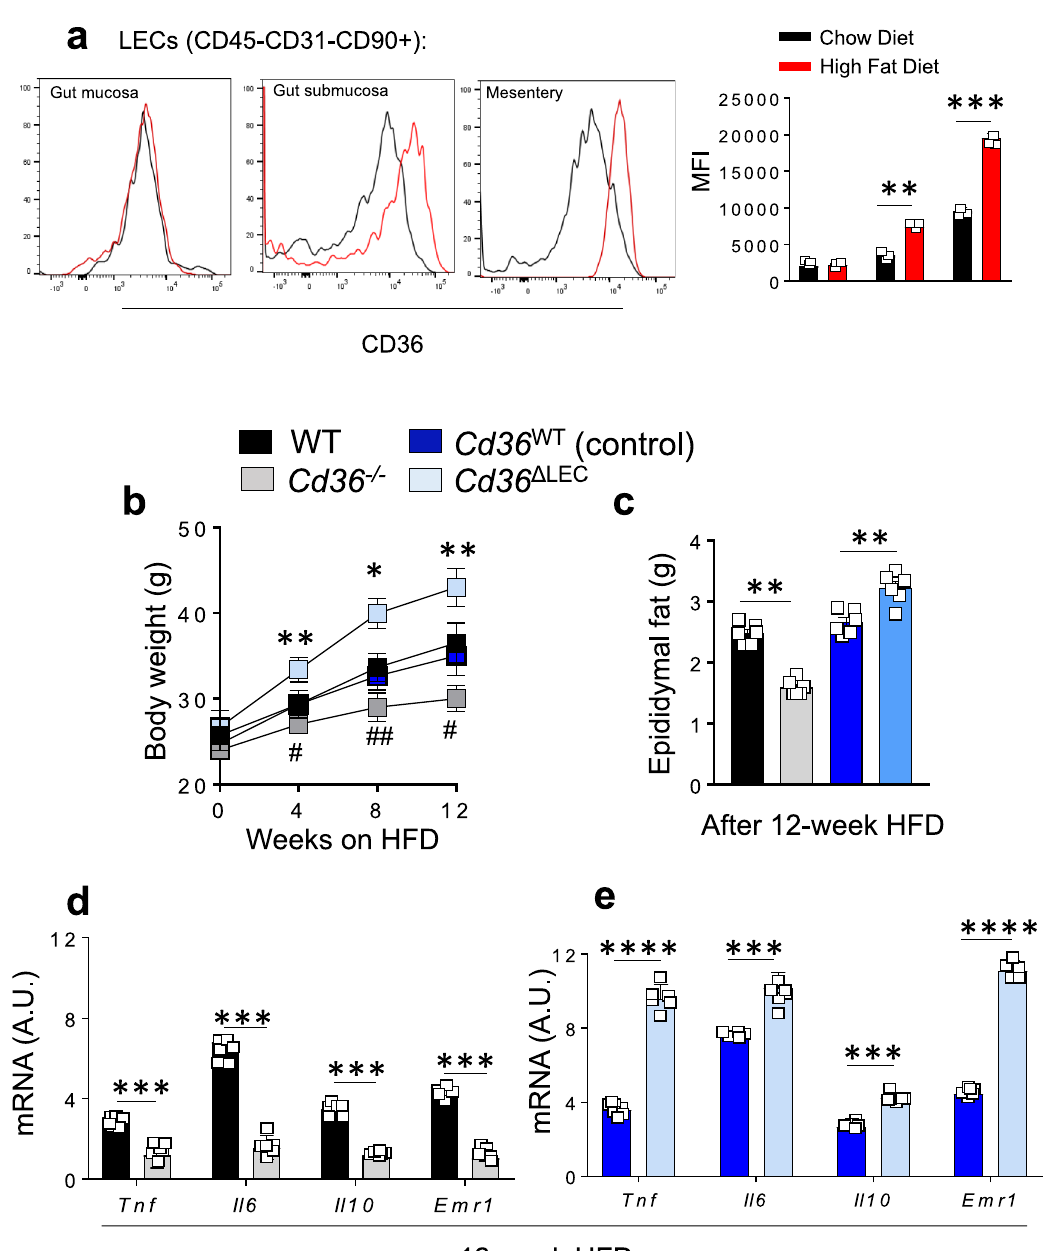
Fig. 6 High-fat diet feeding induces obesity and adipose tissue in fl ammation in Cd36 Δ LEC mice but not in Cd36 − / − mice. a Eight-week-old male and female wild-type (WT) mice ( n = 3) were fed either chow diet (CD) or high-fat diet (HFD) for 12 weeks. CD36 expression was measured by fl ow cytometric analysis in lymphatic endothelial cells (LECs) (CD45 − CD90.2 + CD31 + ) isolated from gut mucosa, submucosa, and mesentery lymphatic vessels. CD36 expression is increased in LEC isolated from gut submucosa and mesenteryic vessels ( P < 0.01 and P < 0.001, respectively). MFI: mean fl uorescence intensity. b Body weight of Cd36 − / − and Cd36 Δ LEC mice, and respective controls ( n = 6), fed HFD for 12 weeks. *Depicts signi fi cance between Cd36 Δ LEC and Cd36 WT mice (4 weeks, P < 0.001; 8 weeks, P < 0.01; 12 weeks, P < 0.001) # , depicts signi fi cance between WT vs Cd36 − / − mice (4 weeks, P < 0.05; 8 weeks, P < 0.01; 12 weeks, P < 0.05). c Epidydimal fat pad weight (g) is decreased in Cd36 − / − mice as compared to WT mice ( P < 0.001), whereas epidydimal fat pad weight is increased in Cd36 Δ LEC mice as compared to controls ( P < 0.01) fed HFD for 12 weeks. d Cytokine gene expression is decreased in Cd36 − / − epididymal adipose tissue as compared to WT mice ( n = 6) fed HFD for 12 weeks. e Cytokine gene expression is increased in Cd36 Δ LEC epididymal adipose tissue as compared to controls ( n = 6) fed HFD for 12 weeks. Tumor necrosis factor alpha , Tnf ; Interleukin-6, Il6 ; Interleukin- 10, Il10; EGF module-containing mucin-like receptor 1, Emr1 . A.U. arbitrary units. All data are from two independent experiments and are means ± SE with n representing the number of mice per group. Statistical signi fi cance is determined by two-tailed Student t test. * and # P < 0.05; ** P < 0.01; ***, P < 0.001; **** P <